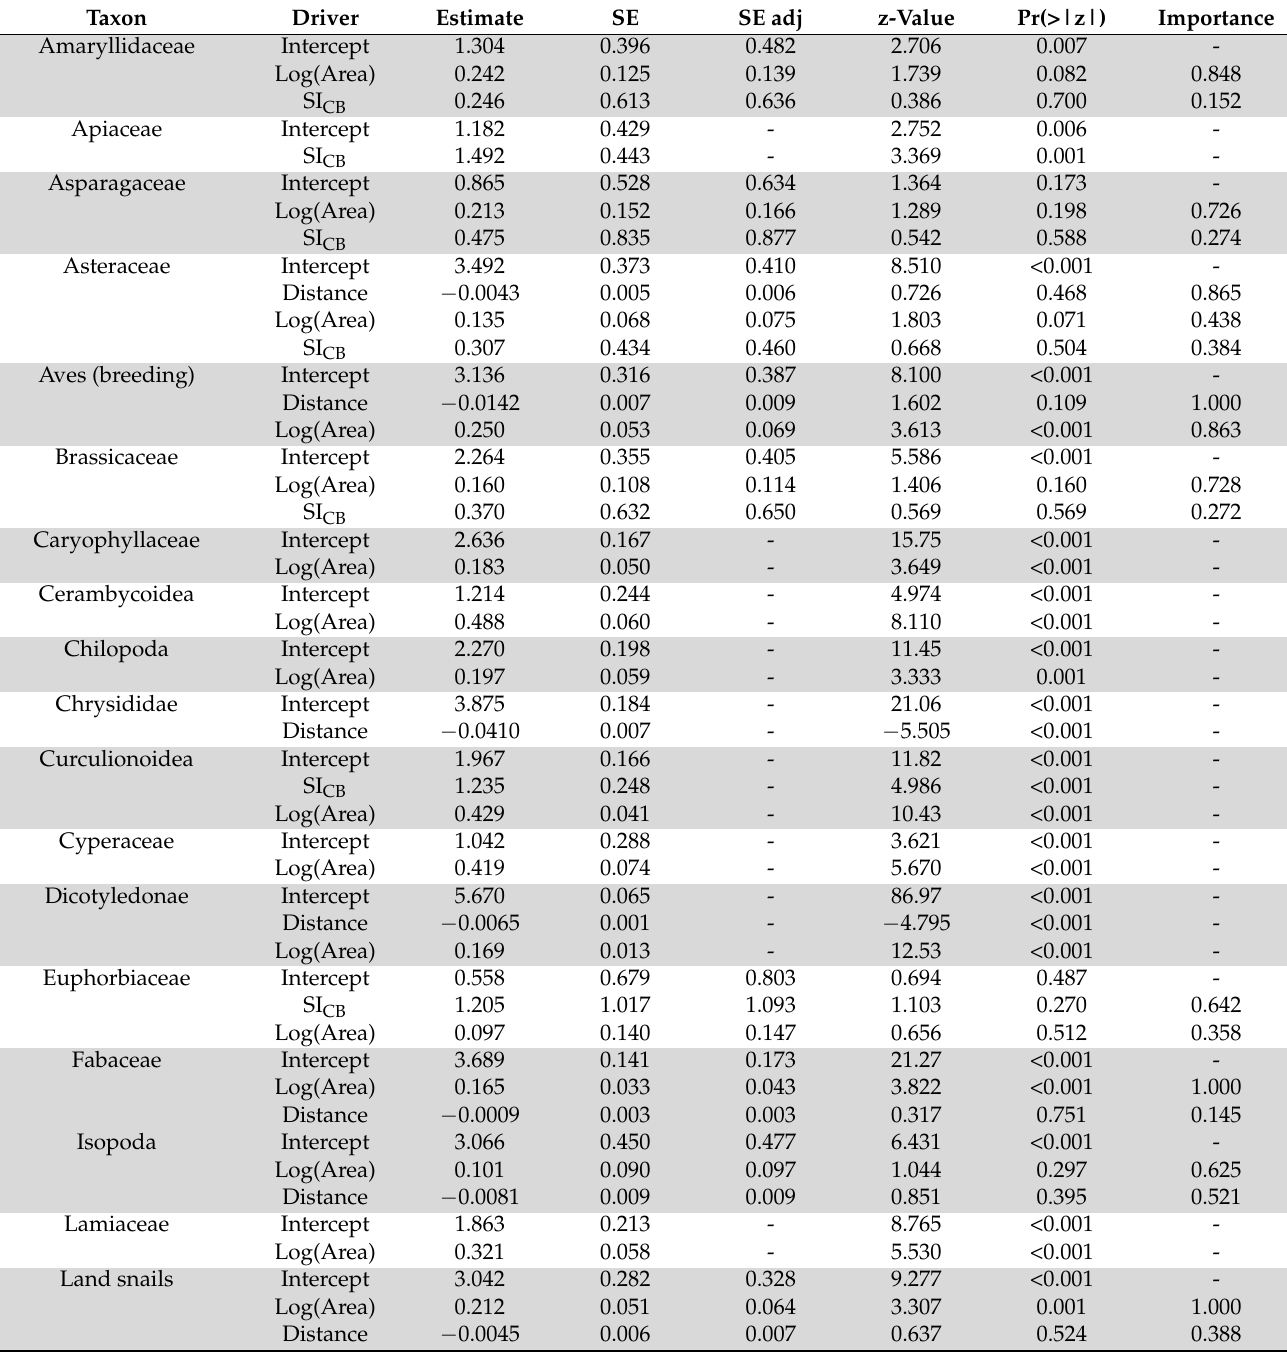
Table 6. Multi-model inference: Coefficient of drivers estimated by model averaging the best models. Estimate: Driver coefficient estimate; SE: Standard error of the coefficient; SE adj: SE adjusted for averaged models only (i.e., when more than one best model was selected); z-value: Standard score; Pr(>|z|): Two-tailed p -values testing the null hypothesis that the coefficient is equal to zero. Importance: Relative importance of the drivers accounted by the hypothesis when more than one best model was